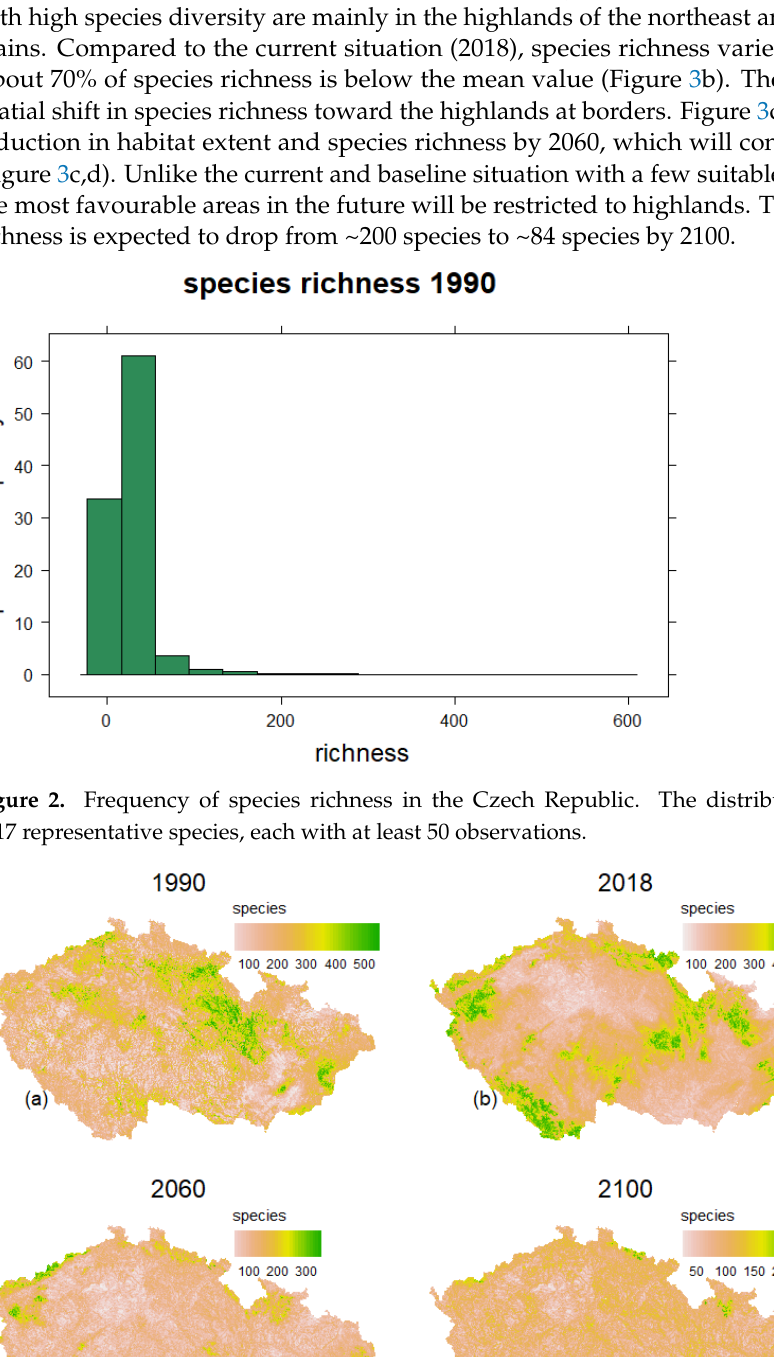
Figure 4. Variability in landscape vulnerability, captured as the mean stable area index (MSAi). ( a ) current (2018) situation, ( b ) 2060 and ( c ) 2100. All changes are with reference to the baseline period (1990). Future changes are based on the RCP 8.5 climate scenario.